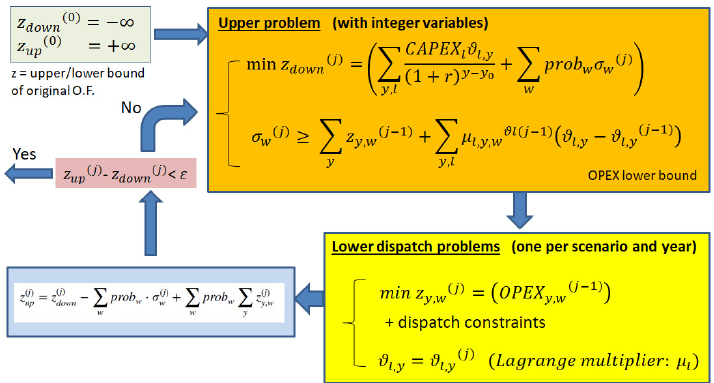
Figure 4. Conceptual scheme of the application on Benders decomposition.